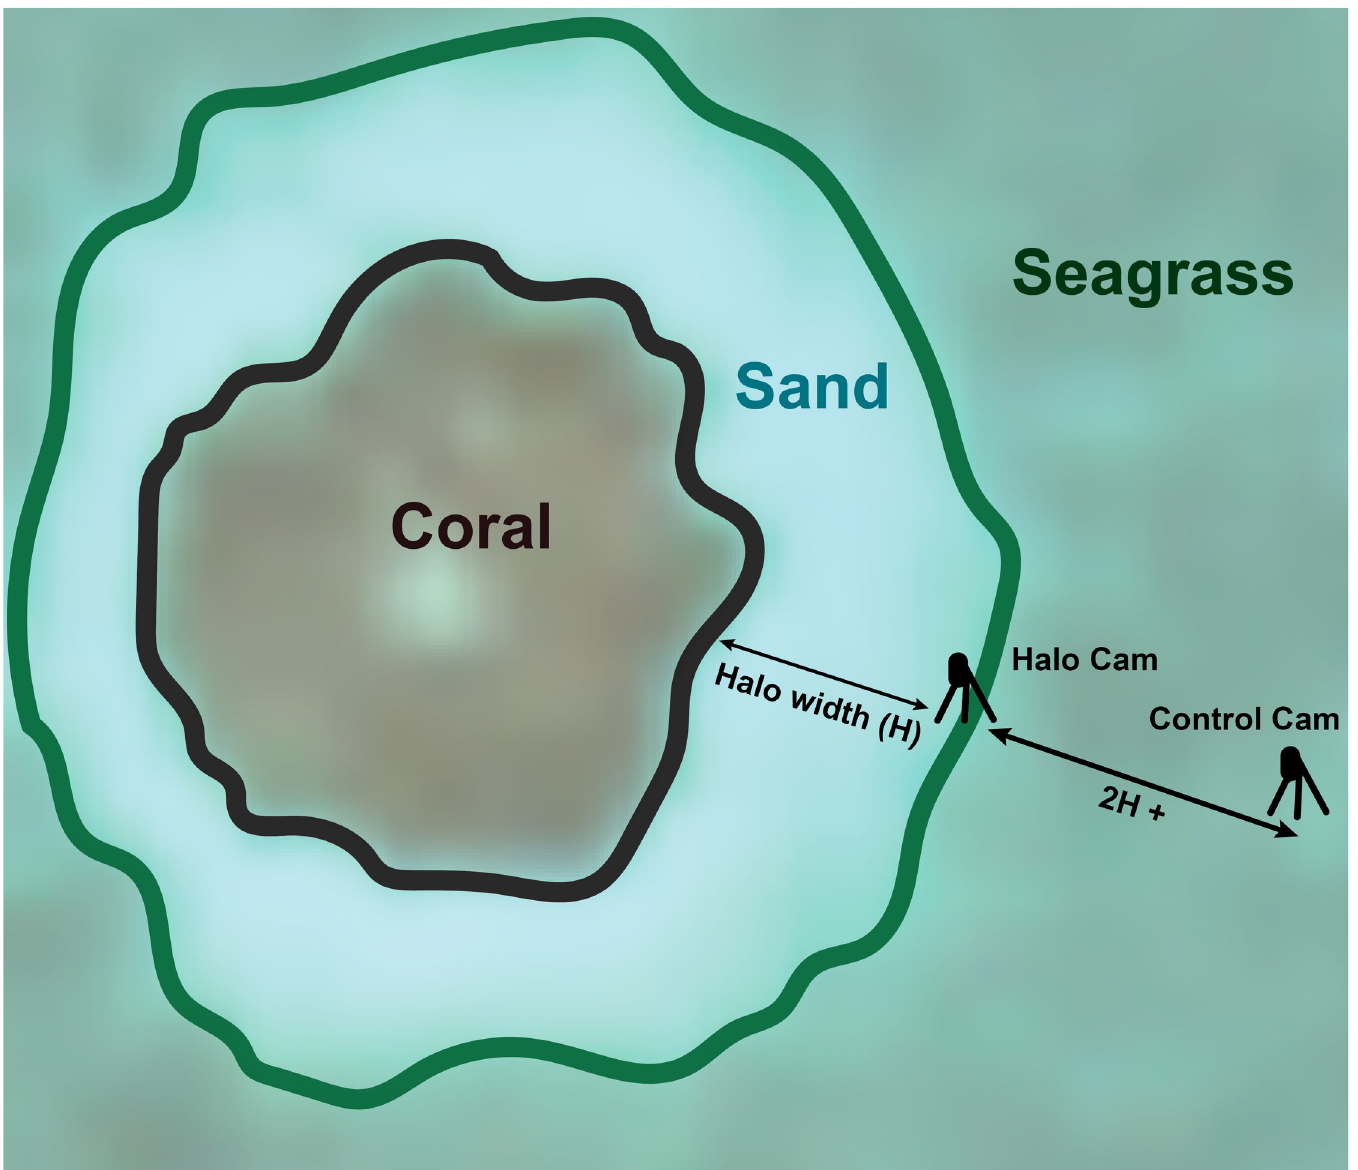
Fig 2. Camera arrangement at a patch reef site. One camera was placed on the edge of the halo facing in toward the reef (“Halo Cam”), while the second (“Control Cam”) was placed twice the halo’s width away in the surrounding seagrass or algal cover, in line with the first camera. Modified from [39] with permission. fishes and other animals. Observations consisted of all divers sitting directly behind each camera for 15 minutes and recording the presence and abundance of all fishes and other animals observed on the reef, in the halo, or in the grass to the genus or species level, when possible. Divers faced forward toward the reef and recorded all fishes observed within the halo or on the reef itself, as this was the primary field of view of the camera. In the seagrass or macroalgae, divers again faced toward the reef and recorded only fishes that swam in front of them and the camera. Divers remained stationary for the entire observation period at each camera. Fish spe- cies and counts were determined by a consensus of all the divers present at each observation.